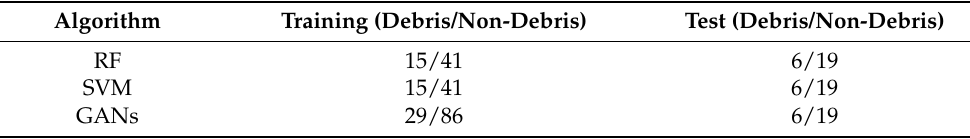
Table 2. The number of training and testing data of plastic debris in the pilot site of Mytilene Island,